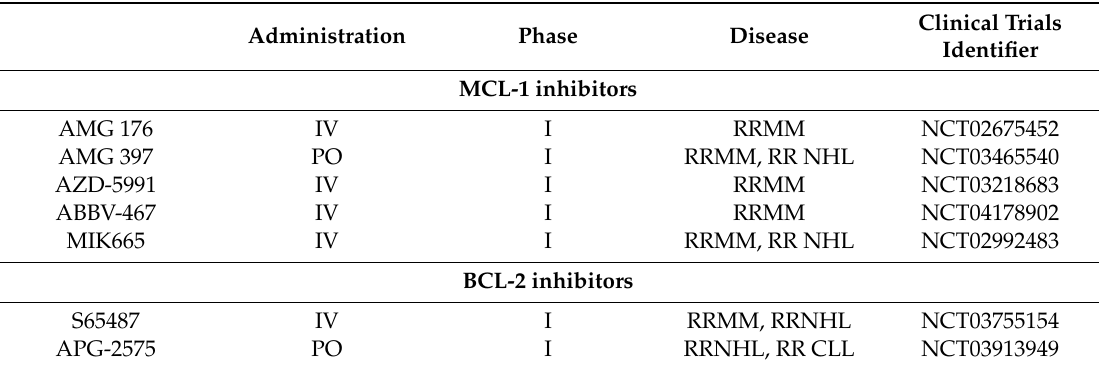
Table 4. New BH3 mimetics under clinical